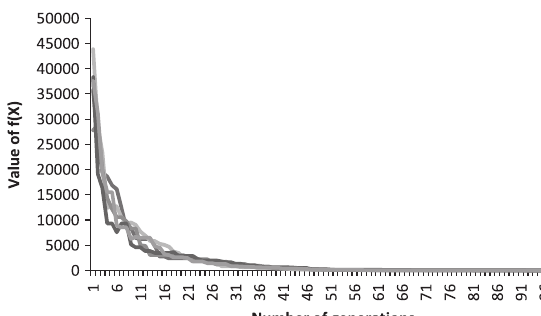
Figure 3. Variation of solution for the sphere function for classical ABC for five different